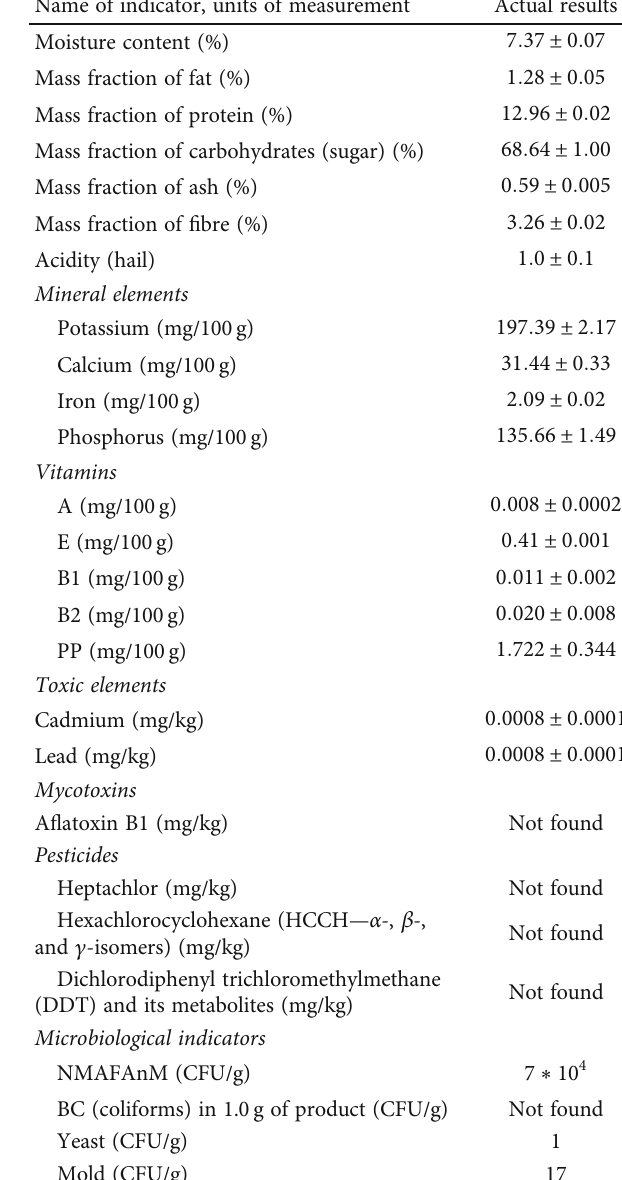
Table 5: Physicochemical and microbiological indicators of the fi rst-grade fl our. Name of indicator, units of measurement